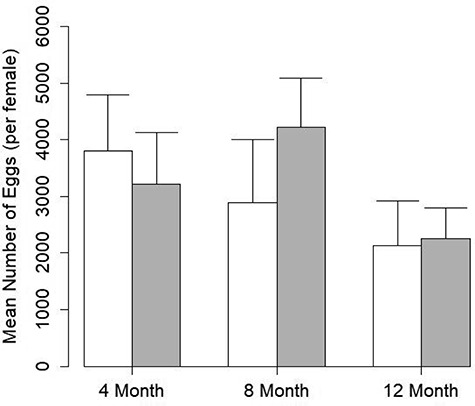
Mean number of eggs produced before and after the assigned temporal period. Mean (+ SEM) number of eggs produced per female for the 4-month (n = 4), 8-month (n = 6) and 12-month (n = 7) treatment. White bars represent mean amount of eggs produced in the first hormone stimulation while shaded bars represent the amount of eggs produced in the second hormone stimulation. Mean number of eggs produced per female was compared to the amount of eggs produced by the same toads after the initial hormone stimulation with a paired t test. No significant difference was observed between the first and second hormone stimulation for any treatment group (P < 0.05)